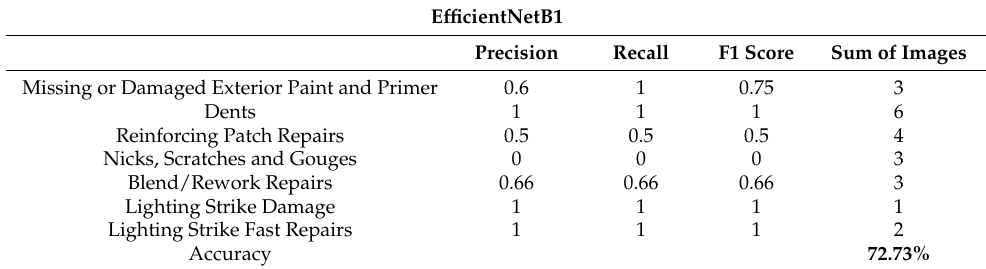
Table 11. Classification report of EfficientNetB1 for defect classification.